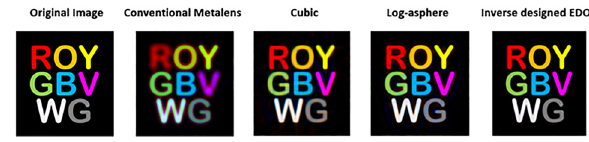
Figure 7: Simulated imaging performance after deconvolution. Deconvolved images captured by the EDOF imaging system, using the simulated images and